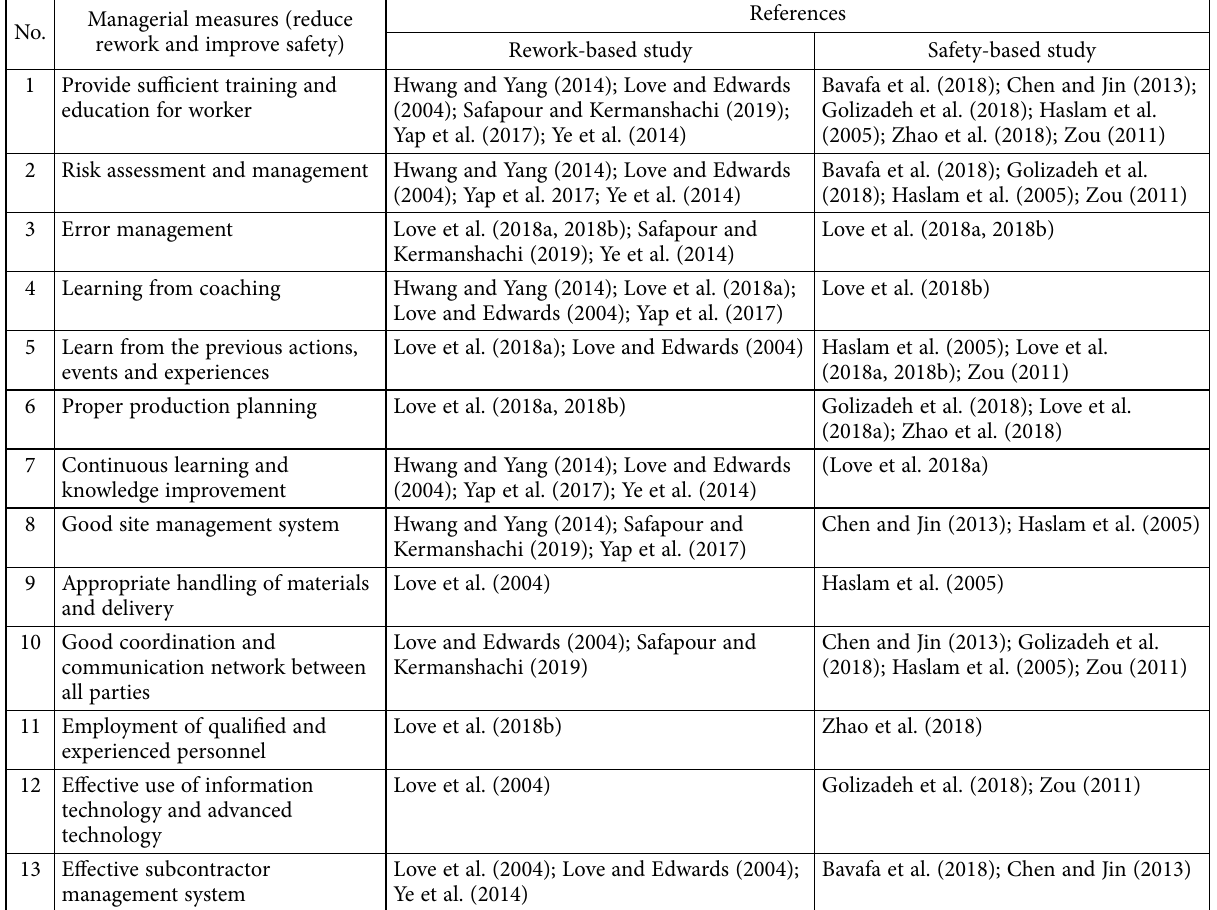
Table 1. Summary of rework management measures that also facilitate construction safety management